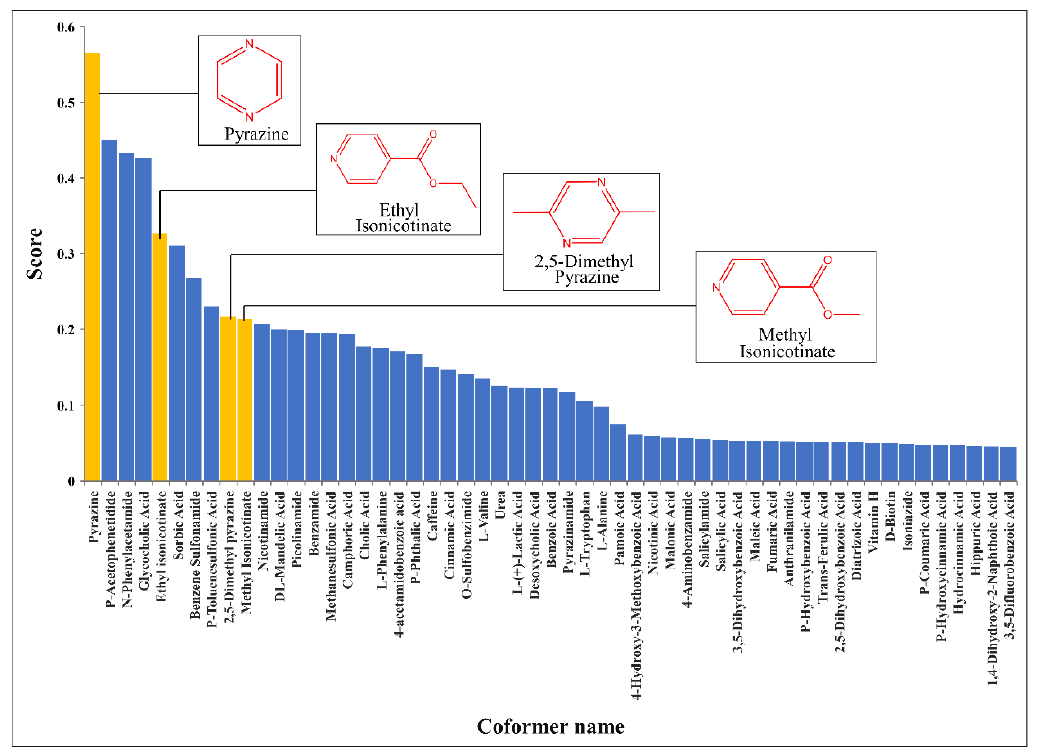
Figure 6. Score ranking of top 55 coformers forming cocrystals with bexarotene by the CocrystalGCN. Four experimentally verified coformers capable of forming cocrystals with BEX are marked in yellow, which are pyrazine, ethyl isonicotinate, 2,5-dimethyl pyrazine, and methyl isonicotinate, respectively.